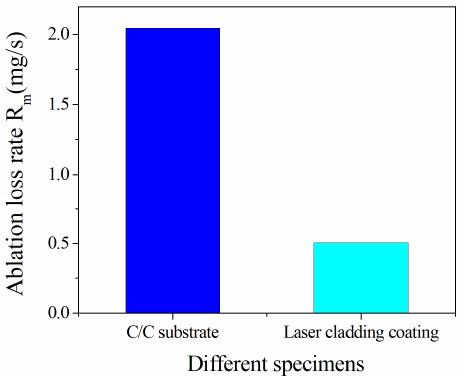
Figure 8. Comparison of oxyacetylene ablation rate between C/C composite matrix and laser cladding coating.